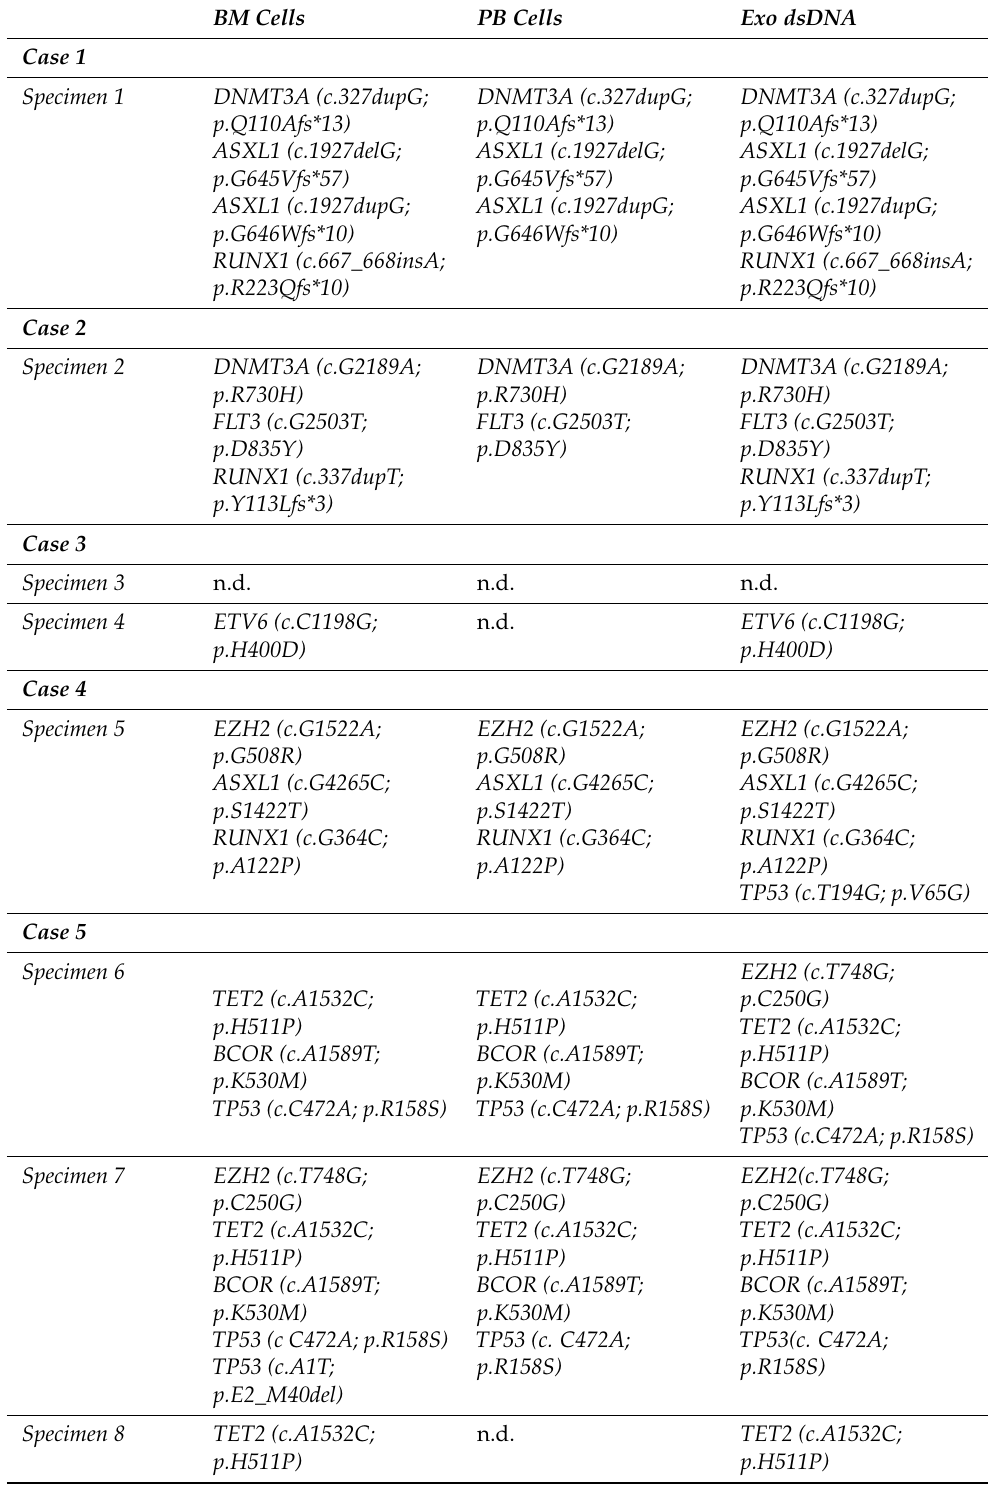
Table 3. Mutations detected in bone marrow cells’ DNA, peripheral blood cells’ DNA and circulating exosomes’ DNA in all the considered time